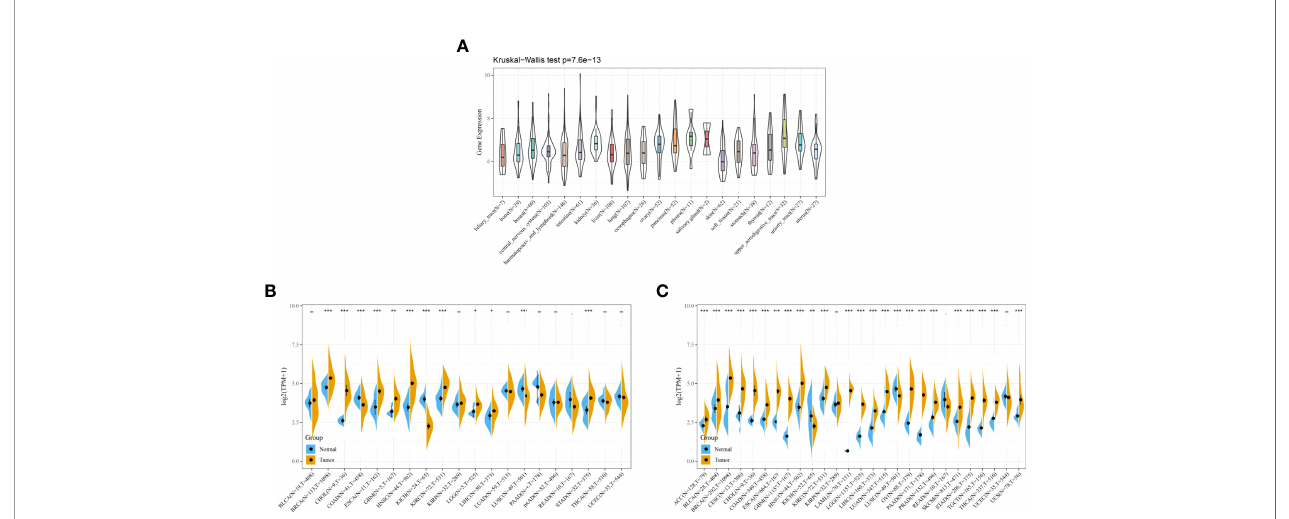
FIGURE 7 | Expression of DDX58 in different cancer types (A) Expression level of DDX58 in different cancer cell lines; (B) Expression level of DDX58 in TCGA; (C) Expression level of DDX58 in the combination of GTEx database and TCGA. * P < 0.05, ** P < 0.01, *** P <